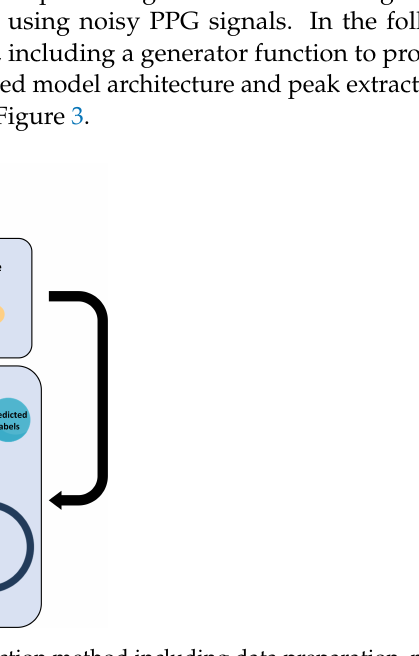
Figure 3. The proposed PPG peak detection method including data preparation, model architecture, and peak